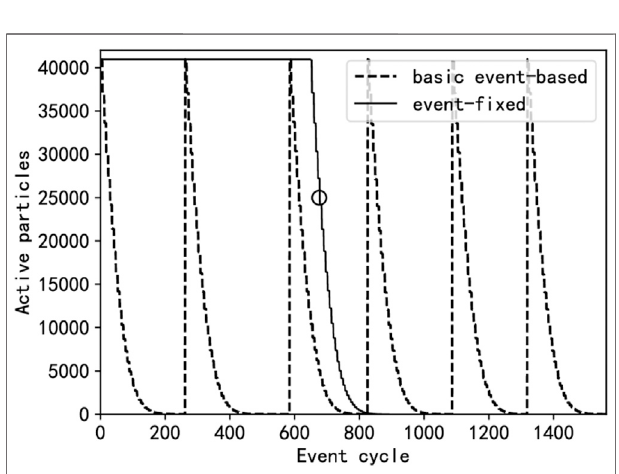
FIGURE 3 | The number of active particles as a function of event cycles forthebasicevent-basedalgorithmandtheevent- fi xedalgorithmwith4 × 10 4 particles per